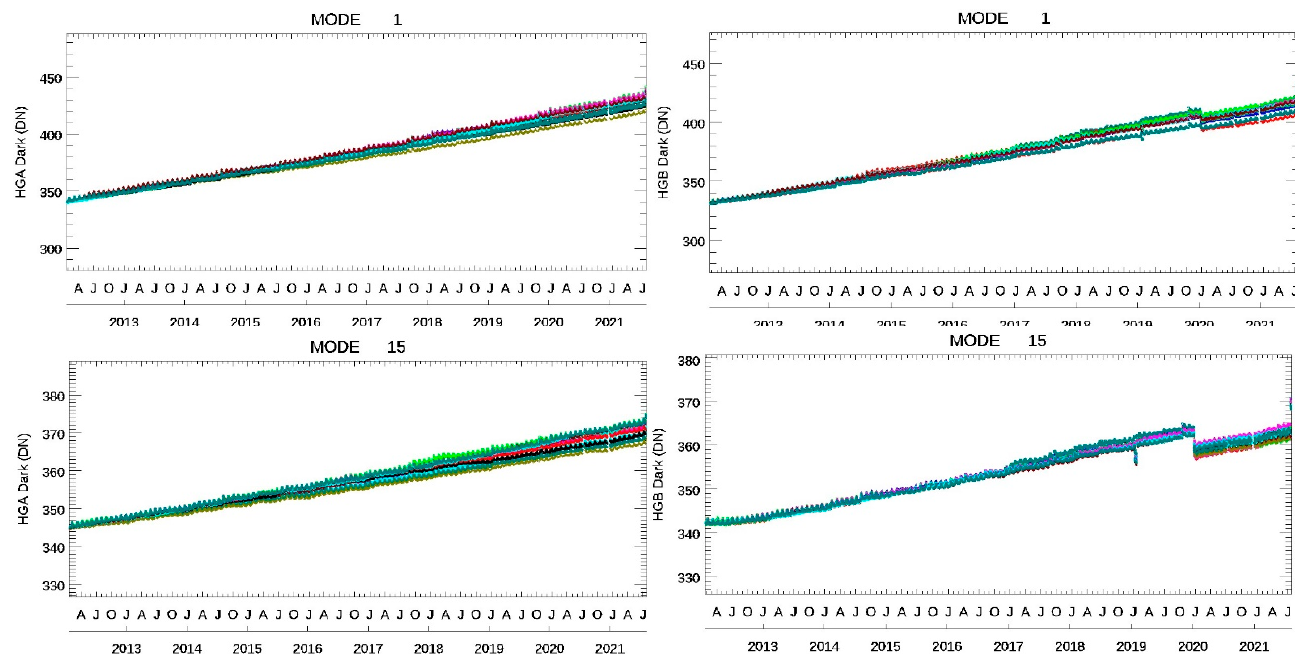
Figure 7. DNB dark signals of HGS-A and HGS-B in mode-1 and mode-15. Different colors are used to plot the DNB 16 detectors.